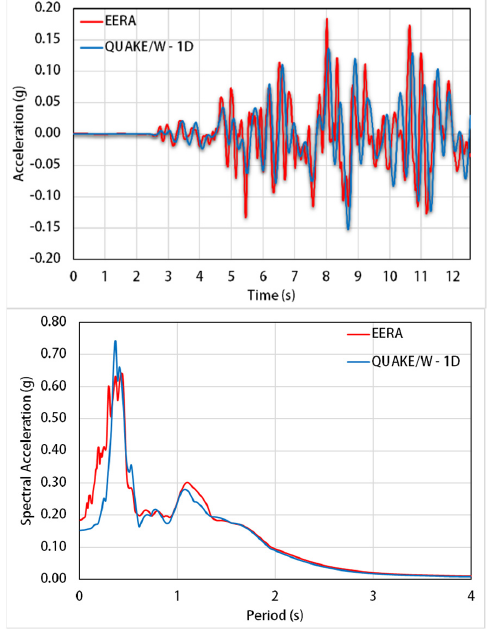
Figure 15. Comparison between 1-D analyses performed by EERA and QUAKE/W for point 3, in terms of acceleration time history and spectral acceleration, for the Amoruso et al. [26] input. Table 5. PGA (Peak Ground Acceleration) by 1-D analyses for the Amoruso et al. [26] input at point 1, 2 and 3.